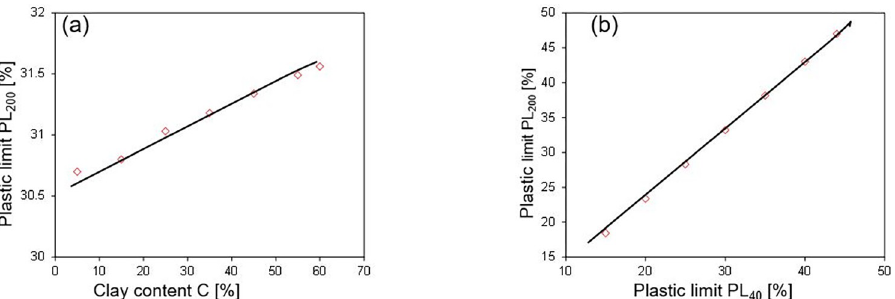
Fig 10. Parametric analysis of input parameters; (a) variation of plastic limit PL 200 with varying clay content C [%]; (b) variation of plastic limit PL 200 with varying silt plastic liquid based on sieve # 40 material